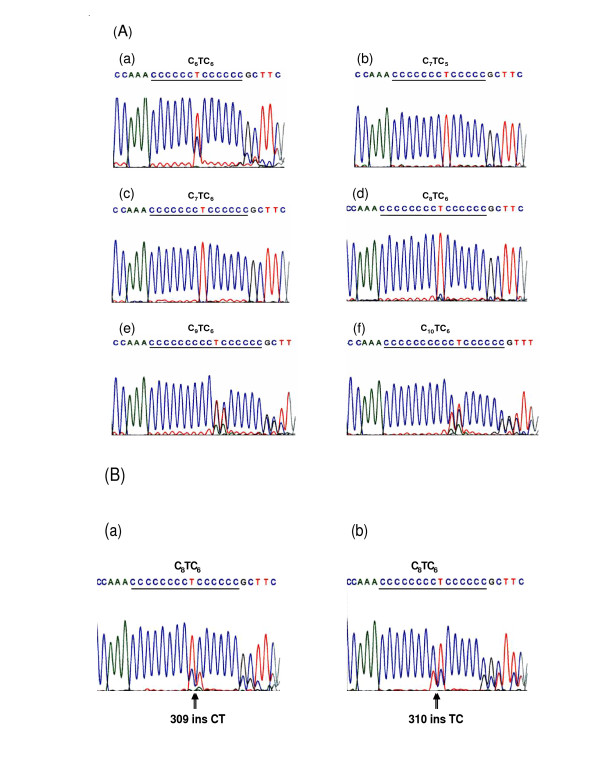
A. MtDNA sequence electropherograms showing variations in consecutive C-stretch at np 303–310 of the D-loop region obtained from the three subtypes of the epithelial ovarian neoplasms (a) C6TC6 and (b) C7TC5 sequences from stage I of endometrioid tumor; (c) C7TC6 and (d) C8TC6 sequences from stage I of mucinous tumor; (e) C9TC6 sequence obtained from stage III of mucinous tumor; (f) C10TC6 sequence from stage III of serous tumor. Interestingly, the C-stretch instability at np 303–315 was observed in 97% of our study samples. B. Sequence electropherograms showing the mtDNA instability at np (a) 309insCT in stage II of endometrioid tumor and (b) 310insTC observed only in early stages of serous subtype in this study. Arrow shows the unique 309insCT and 310insTC patterns respectively.